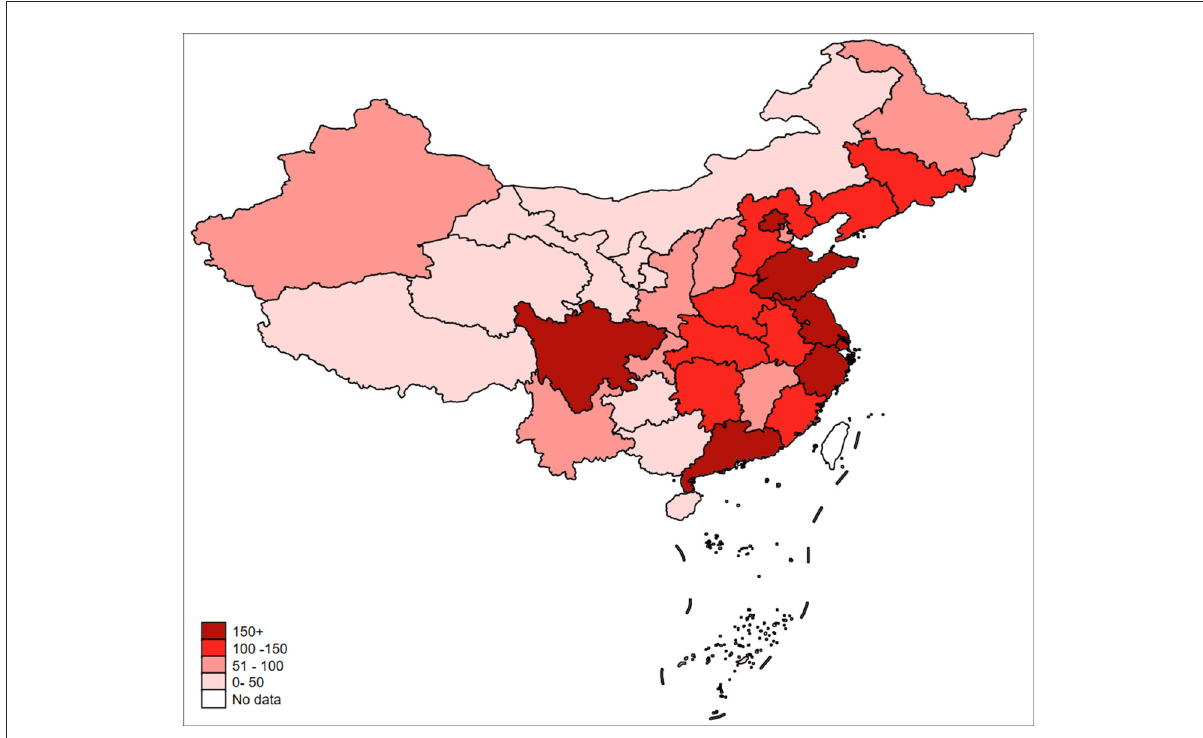
FIGURE1 Severity of air pollution in each province in